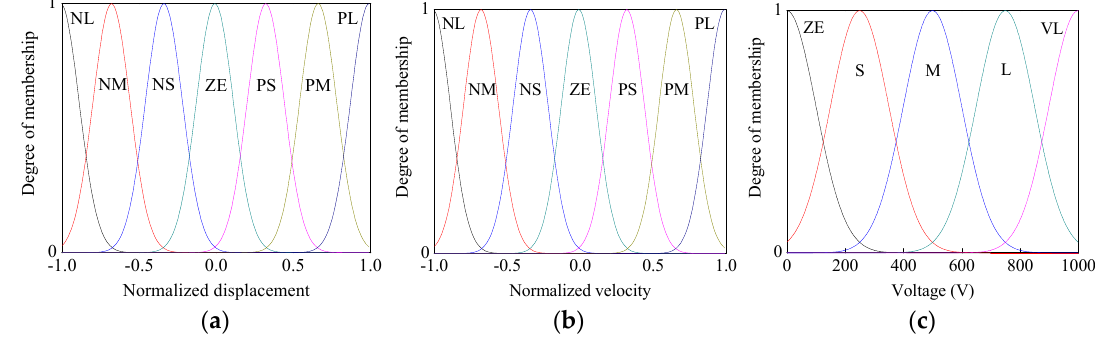
Figure 5. Input and output membership functions for sub-level fuzzy controller: ( a ) input normalized displacement; (b) input normalized velocity; and ( c ) output voltage. Table 3. Fuzzy rule base for sub ‐ level FLC.